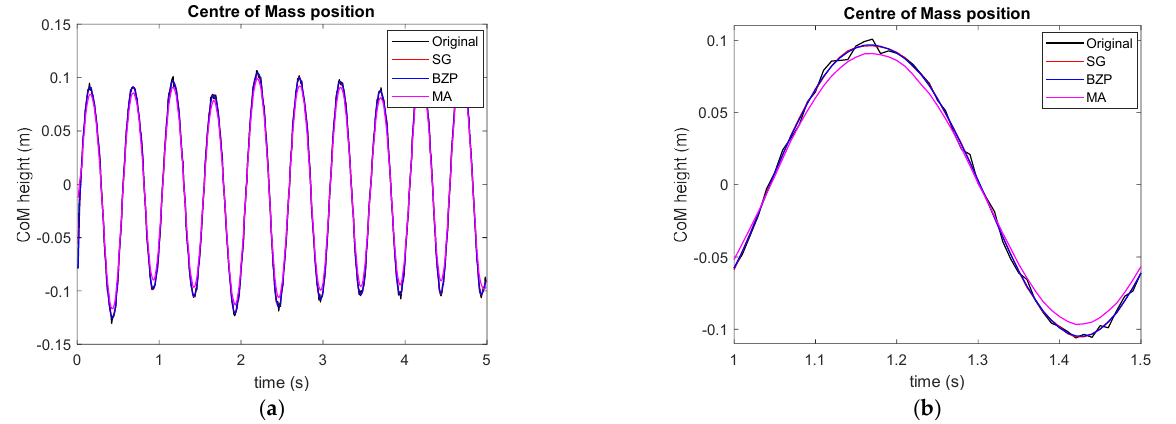
Figure 7. CoM vertical position during hopping. Complete acquisition ( a ) and detail ( b ). Figure 8 presents signal derivatives or CoM vertical speed and acceleration.